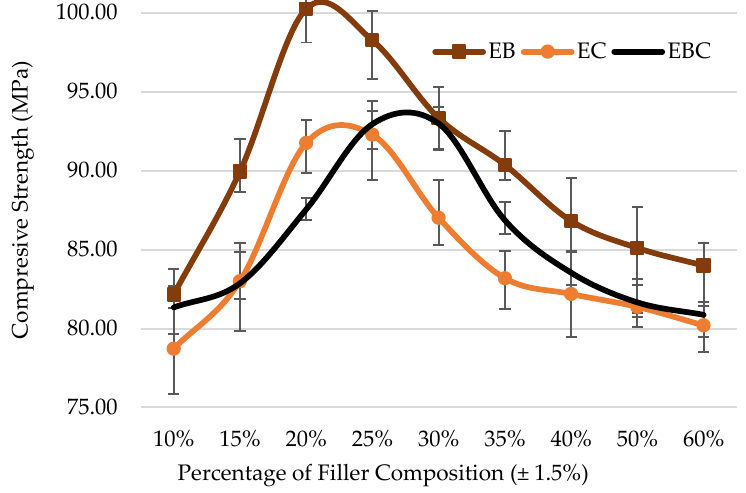
Table 10. Summary of compressive strength values for EBC, EB, and EC.